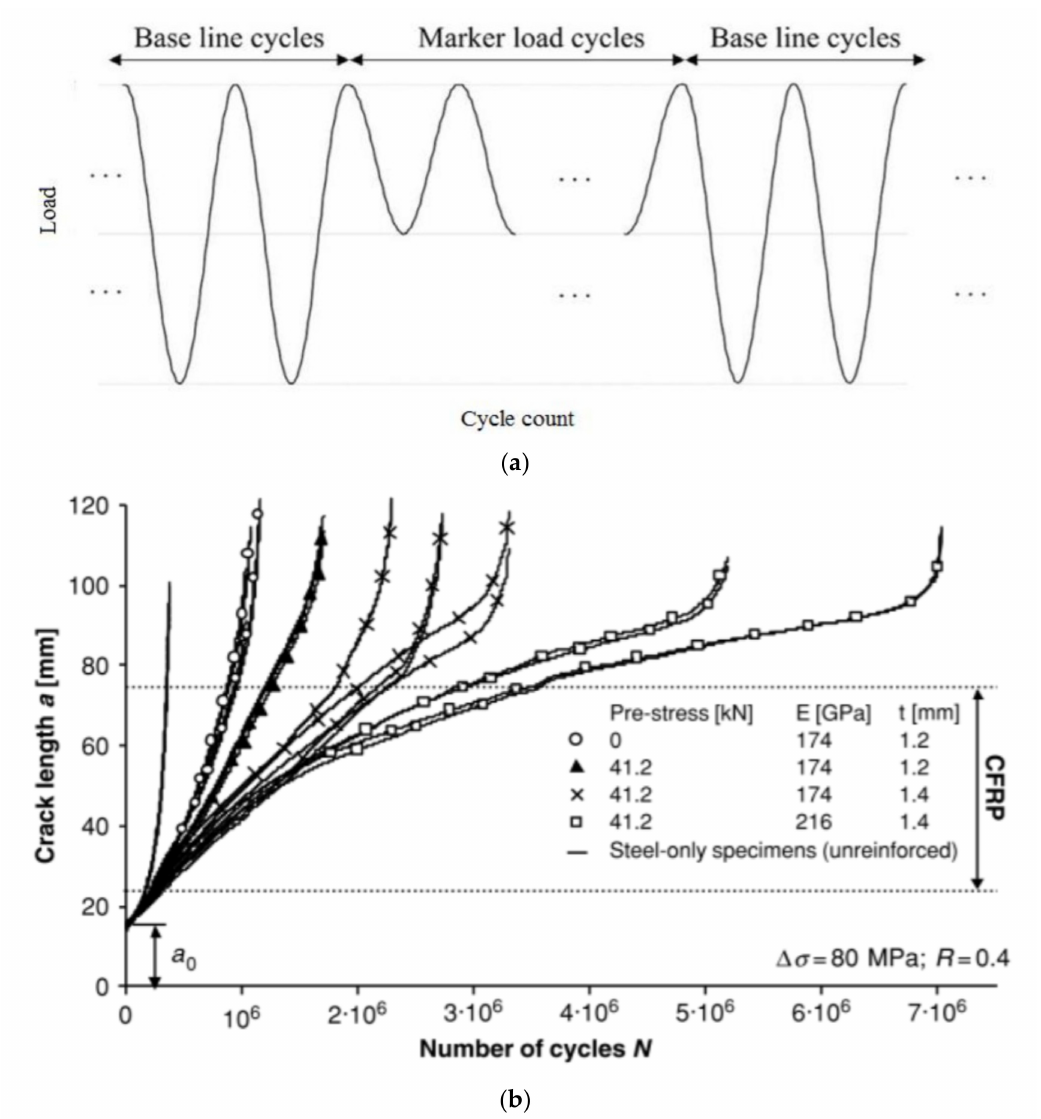
Figure 10. ( a ) Schematic representation of “beach marking” cycles adapted from [120], with permission from Thin-Walled Structures, Elsevier, 2021. ( b ) Crack propagation curves of tests conducted at the SFIT, published in [121]; used with permission from Fatigue & Fracture of Engineering Materials & Structures, John Wiley & Sons Ltd.,